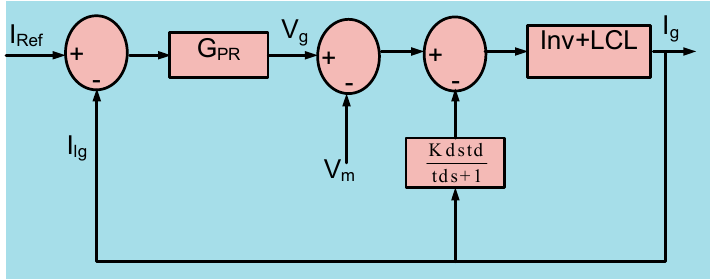
Figure 16. Block diagram of PR-D controller.